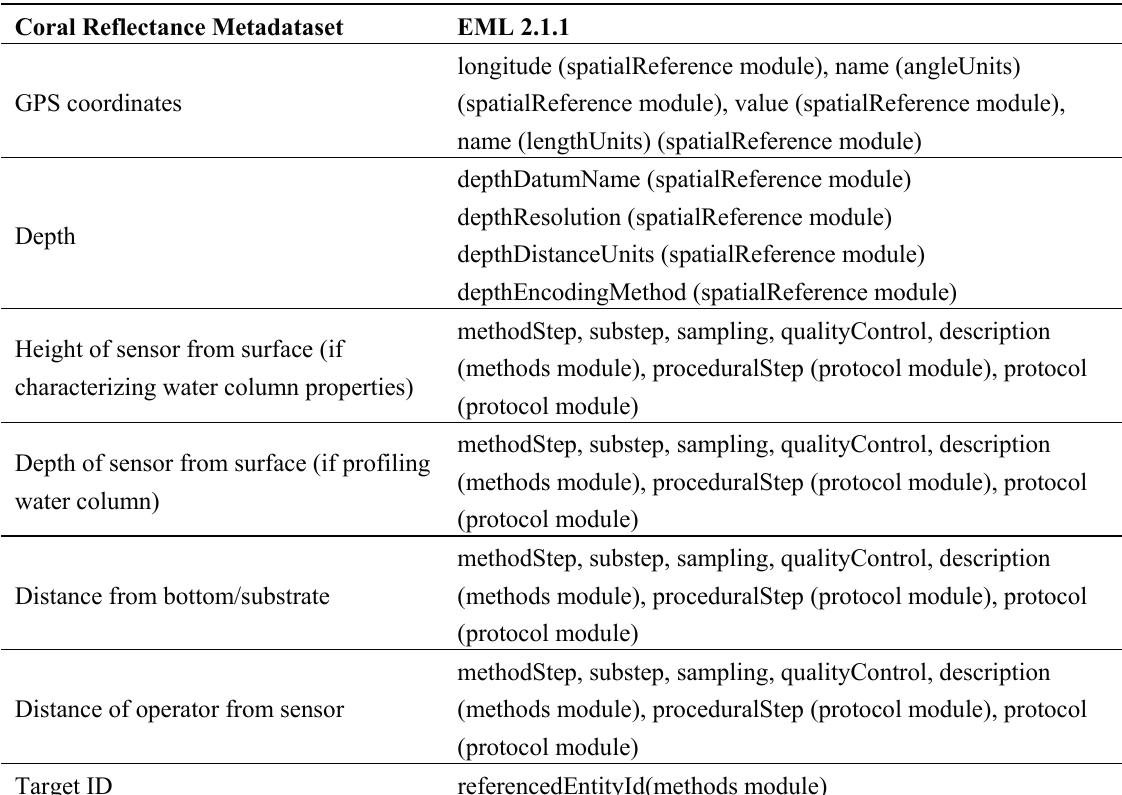
Table A11. Mappings from Ecological Metadata Language 2.1.1 to the underwater benthic reflectance metadataset.